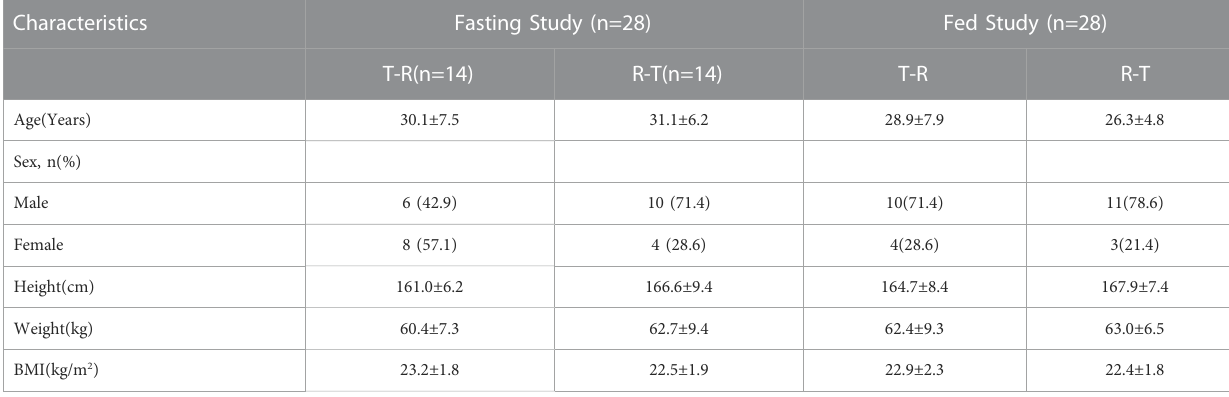
TABLE 1 Baseline demographics of study participants.